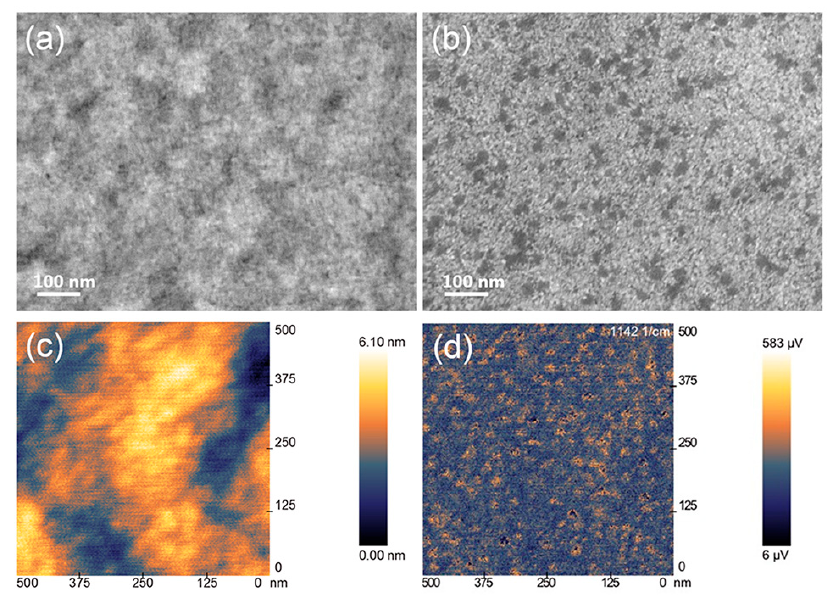
Figure 3. SEM images of ( a ) ZnO film and ( b ) ZnO / ETP blend film, ( c ) AFM topography image, and ( d ) photo-induced force microscopy (PiFM) image of ZnO / ETP blend film.